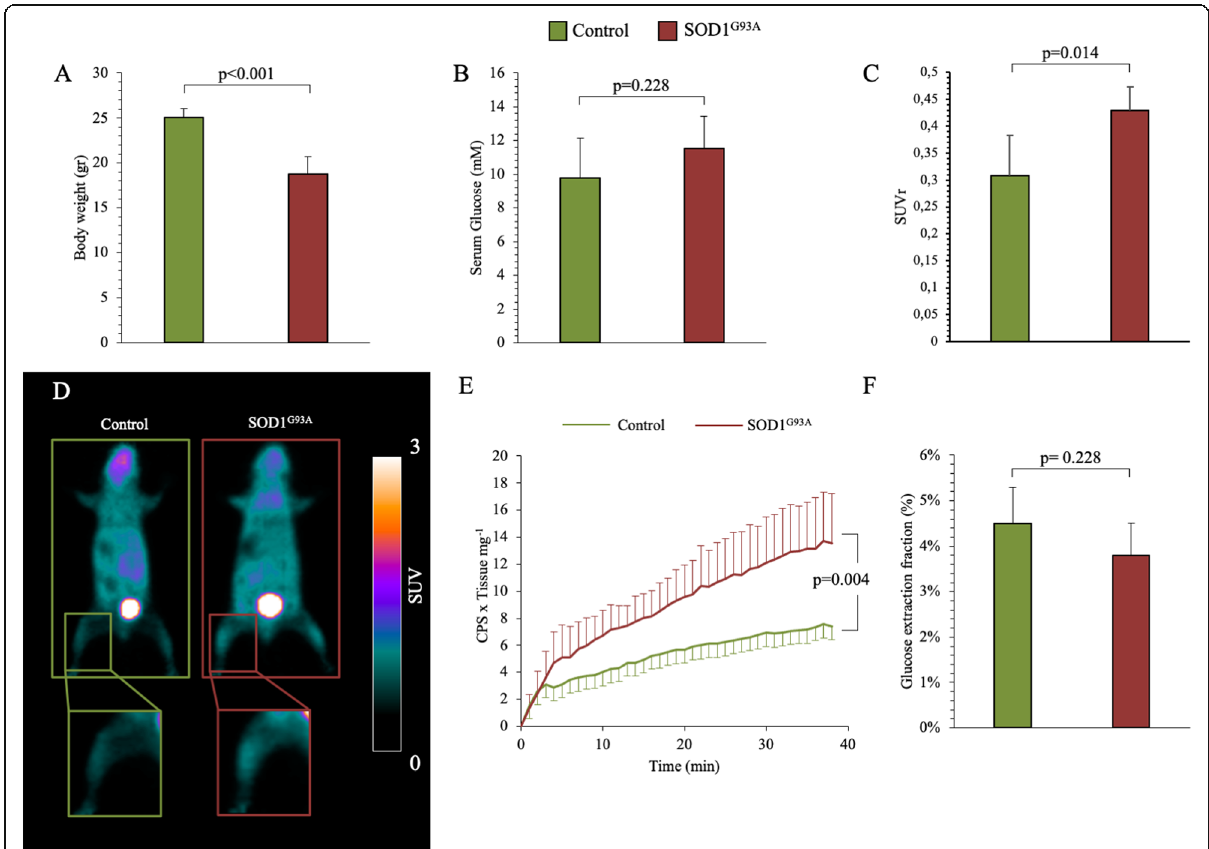
Fig. 1 In vivo and ex vivo effects of SOD1 G93A mutation in skeletal muscle. a , b Bodyweight and serum glucose levels in controls (green column) and SOD1 G93A mice (red column). c Average of FDG retention expressed as standardized uptake value ratio (SUVr) in control (green column) and SOD1 G93A skeletal muscle (red column). d Representative hindlimb SUV of control and SOD1 G93A mice. e Average time-course of “ ex-vivo ” radioactivity expressed as a fraction of the FDG dose measured by the Ligand-Tracer White® device, in quadriceps harvested from control (green line) and SOD1 G93A mouse (red line). f Ex vivo glucose consumption of harvested quadriceps from control (green column) and SOD 1G93A mouse (red column). Data are expressed as mean ± SD; a – d n = 5 for each group; e , f n = 3 for each group. Student t test for unpaired data was used for statistical